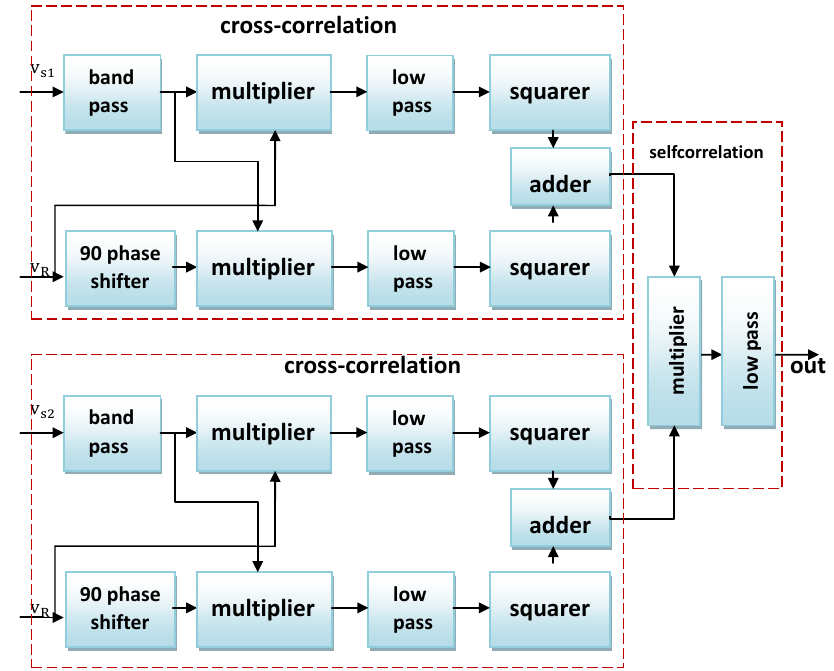
Figure 12. Schematic diagram of cross-and-self-correlation detection. cross-correlation